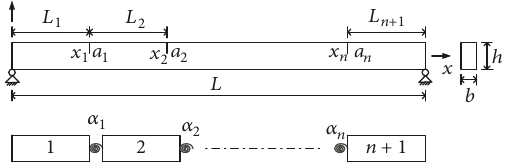
Figure 1: Model of the simply supported steel beam with multiple